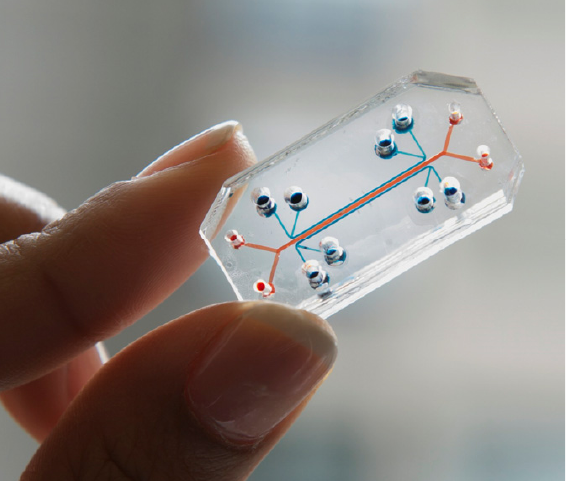
Figure 16. Lung-on-a-chip device developed by [104] to test drugs. A porous membrane placed between two chambers was lined on each side with two different cell types: an alveolar epithelium on one side and a capillary endothelium on the other. By applying a vacuum to two additional lateral microchambers, an elastic deformation is produced in the membrane and its two layers of tissue. Once the vacuum is released, the membrane and attached cells relax to their original size, thus replicating the dynamic mechanical distortion of the alveolar–capillary interface that is generated during the breathing process [105], as represented in Figure 17.